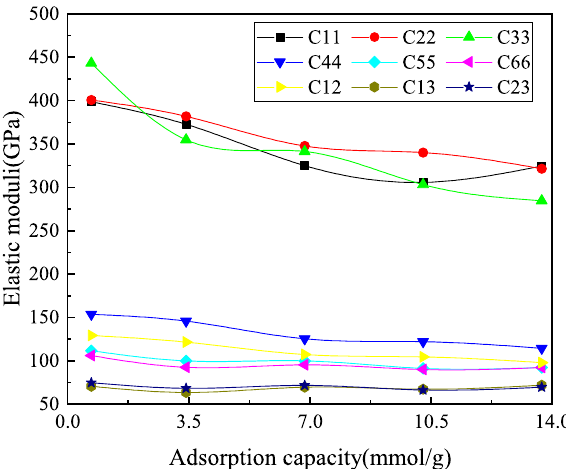
Figure 9. Elastic constants of montmorillonite change according to adsorption capacity.